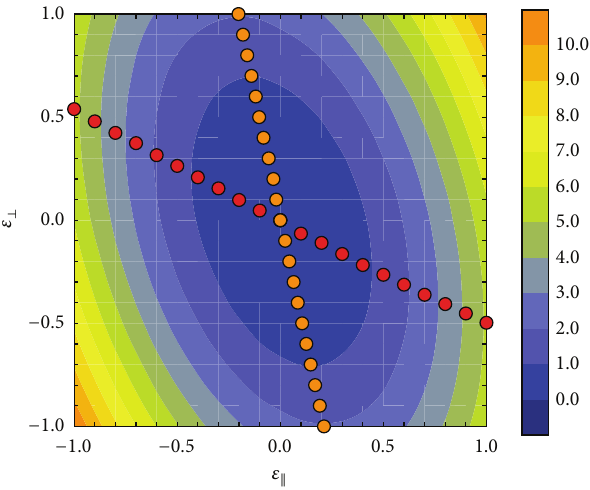
Figure 1: Contour plot of the total energy in meV per unit cell as a function of the in-plane strain parameter 𝜀 ‖ and the out-of-plane parameter 𝜀 ⊥ formonoclinicdeformationsalongthe [110] direction. The orange and red dots refer to configurations with uniaxial and biaxial strains,